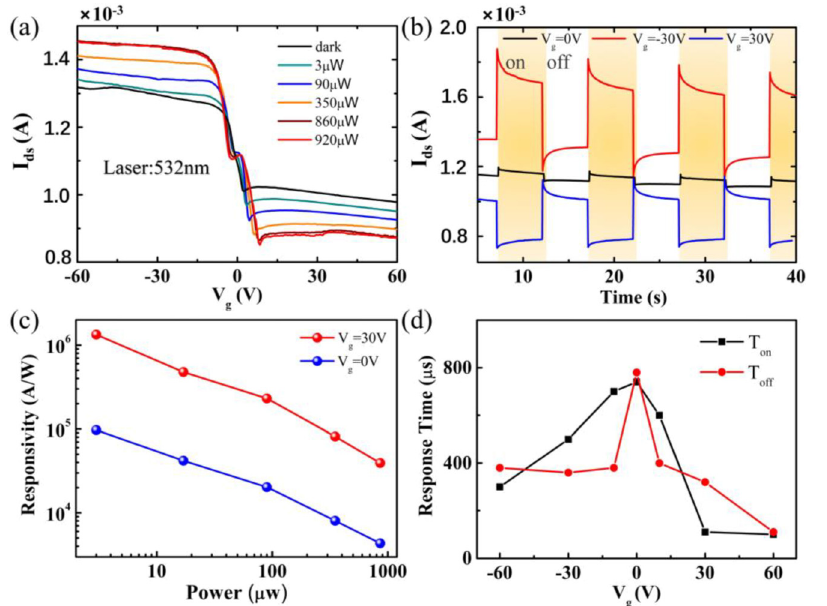
Figure 5: (a) I ds as a function of V g under 532 nm illumination light with different optical power. V g increases from − 60 to 60 V. (b) I ds -Time curve of the device when V g = 0 V, − 30, and 30 V. (c) Responsivity versus light power when V g = 30 and 0 V. (d) Response time at different vertical